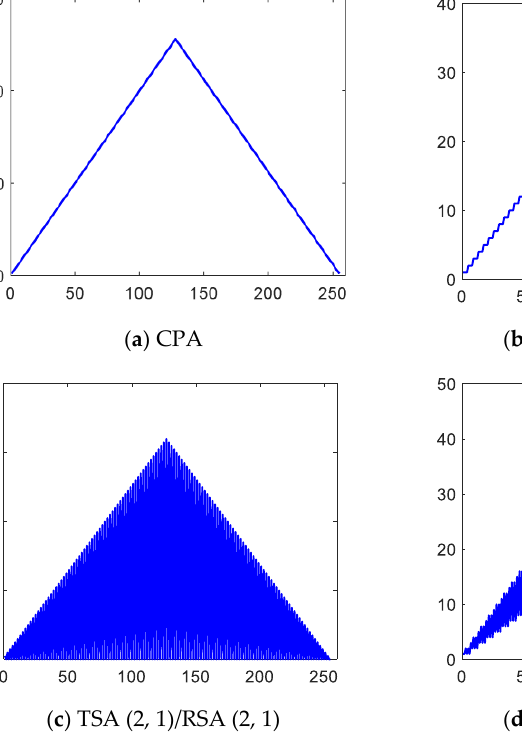
Figure 5. Comparison of effective aperture.